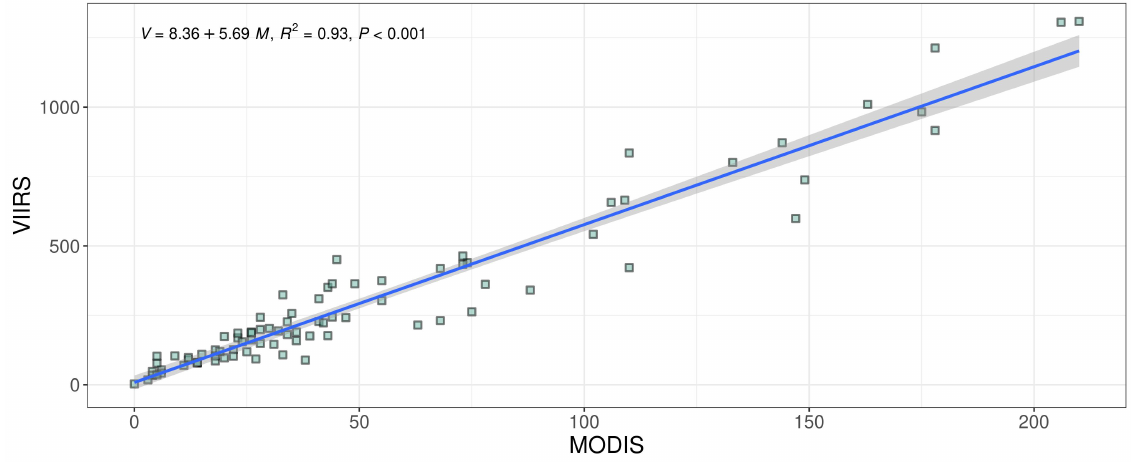
Figure S4 – Scatter plot of the number of fire points per month sensed by MODIS and VIIRS sensors for the period 2012-2018